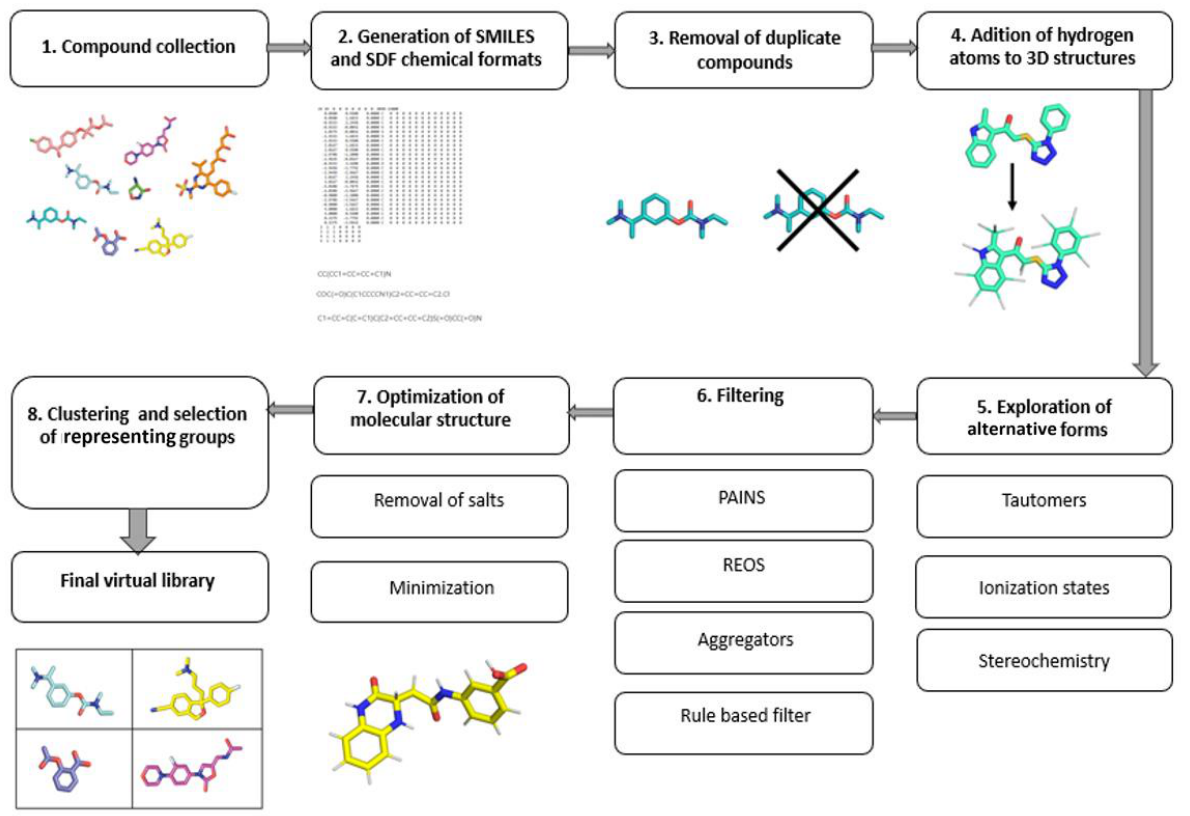
Figure 2. Workflow of an efficient library preparation for medicinal chemistry.